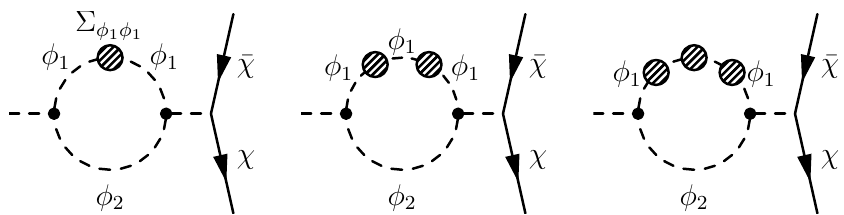
Figure 4. Examplary Feynman diagrams appearing in the resummation of φ 1 contributions. The hashed dots denote the one-loop φ 1 self-energy ˆΣ (1) 11